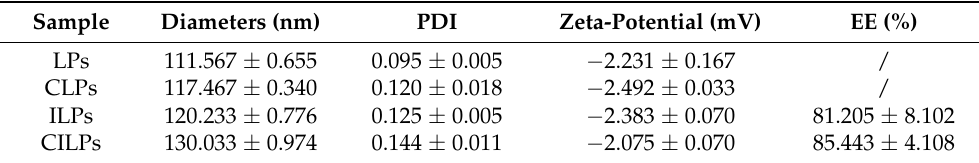
Table 1. The diameters, zeta-potential, PDI, and EE of LPs, CLPs, ILPs, and CILPs, respectively.